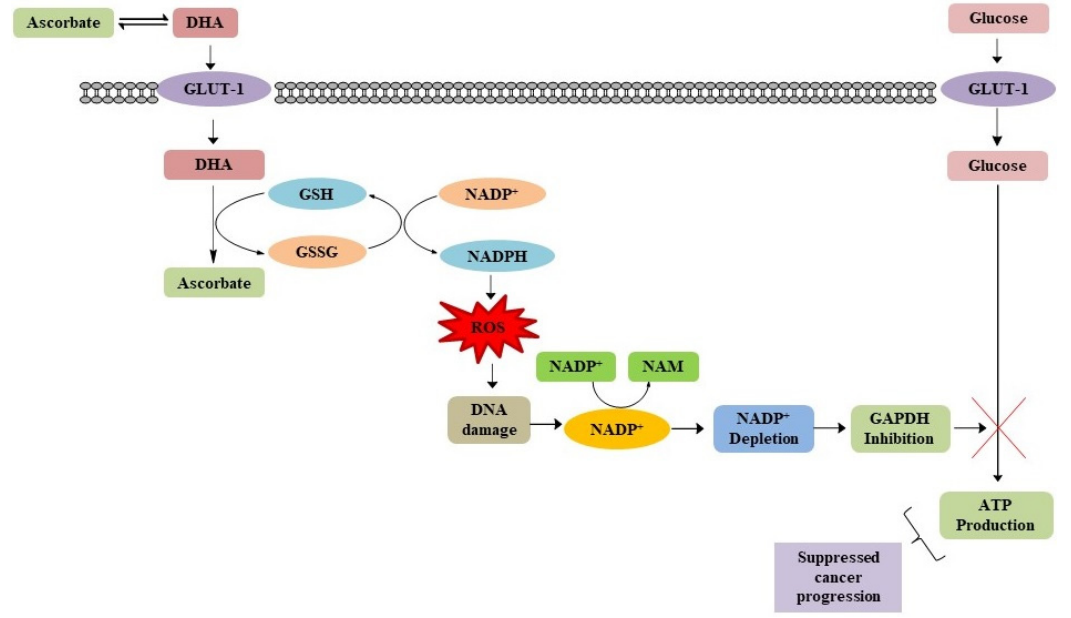
Figure 7. Role of ascorbate in impairing glucose metabolism in cancer cells [41,46,51–53].